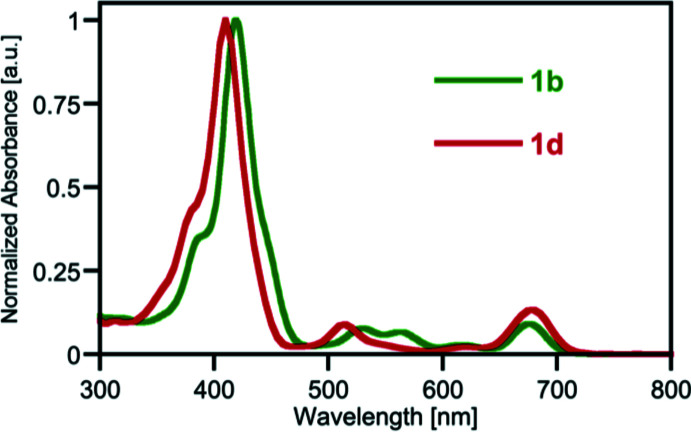
Normalized UV–vis spectra (CH2Cl2) of the compounds indicated.